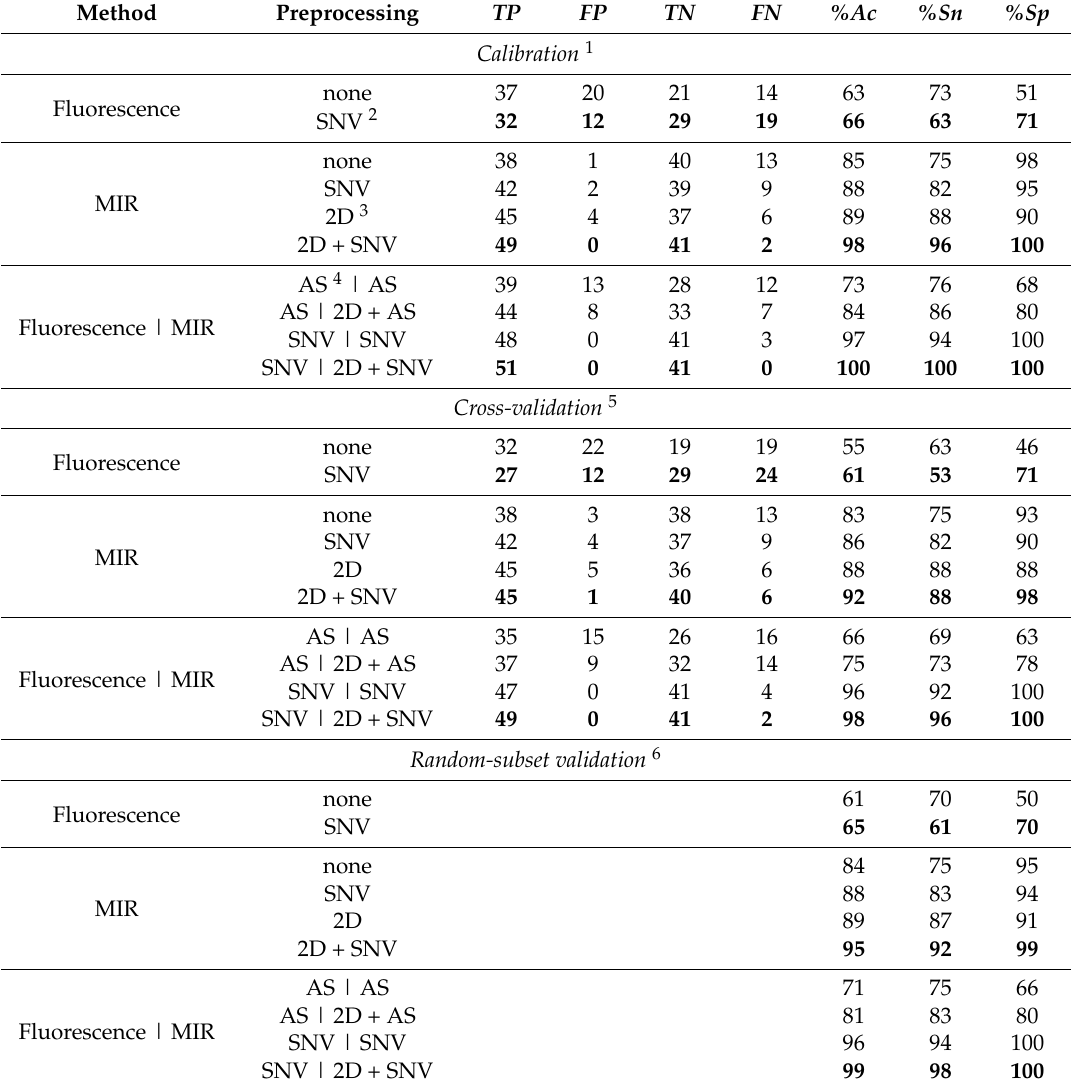
Table 1. Comparison of spectroscopic methods for kidney cancer diagnostics; two latent variables (LVs) were used in all